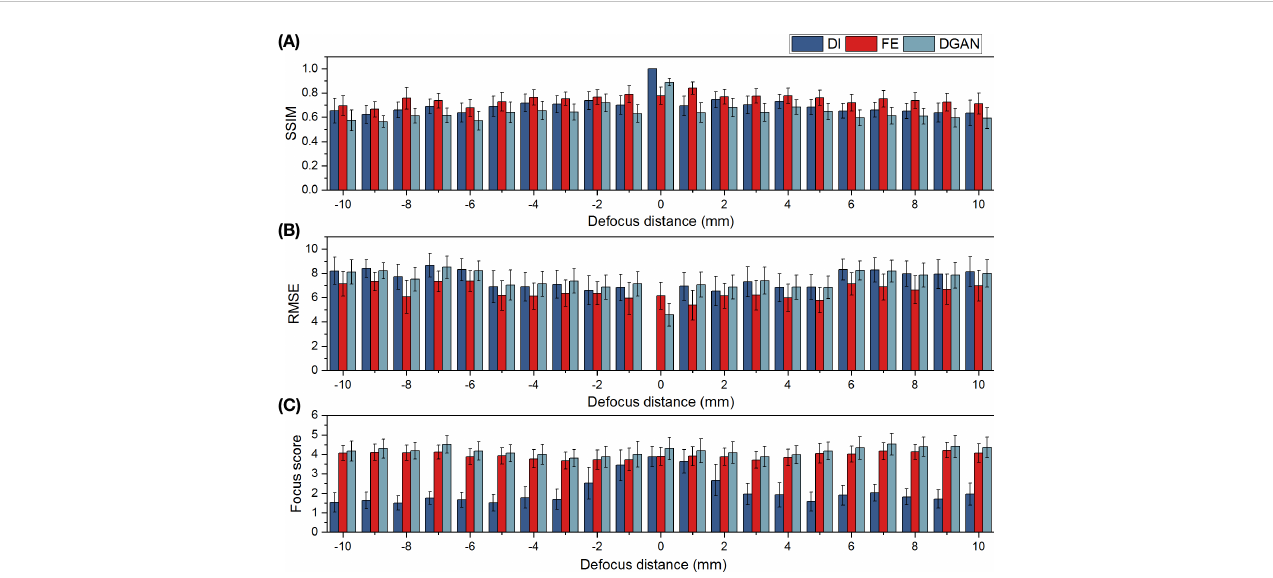
FIGURE 6 Quantitative comparisons of the focus-extension performances of the DeblurGAN-v2 and IsPlanktonFE networks on restoring marine plankton images with metrics of SSIM (A) , RMSE (B) and focus score (C) . Here larger SSIM ( ∈ [0,1]), smaller RMSE, and higher Focus score indicates sharper image focusing state,